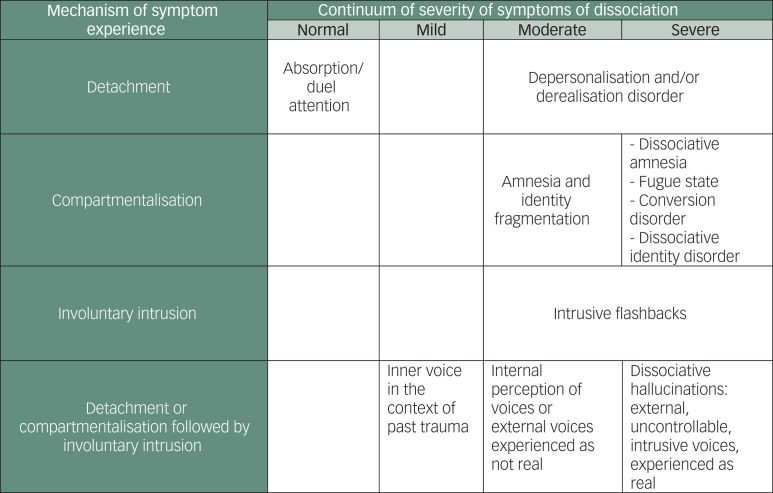
Mechanisms of symptom experience in dissociation. Adapted from Cardena24 and Steel et al6.